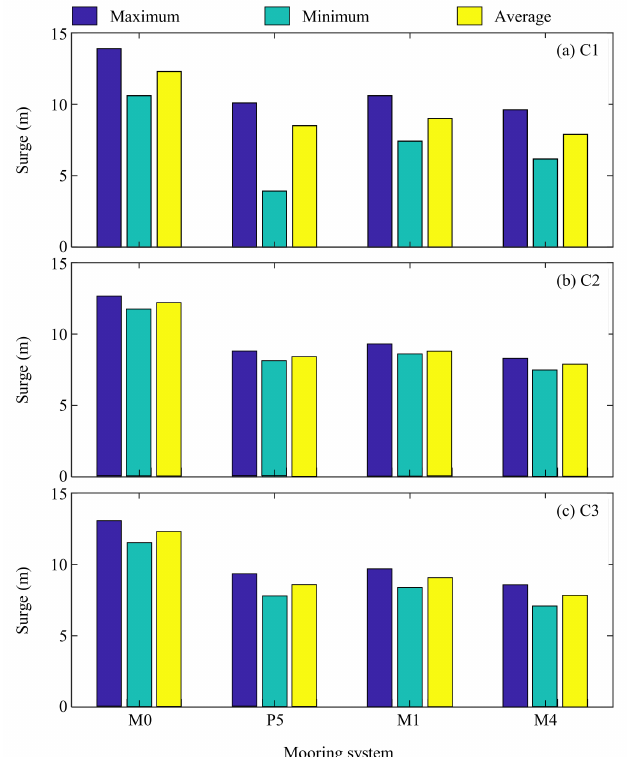
Figure 17. Maximum, minimum, and average values of wind turbine surge movement time series with M0, P5, M1, and M4 when under: ( a ) C1; ( b ) C2; ( c )